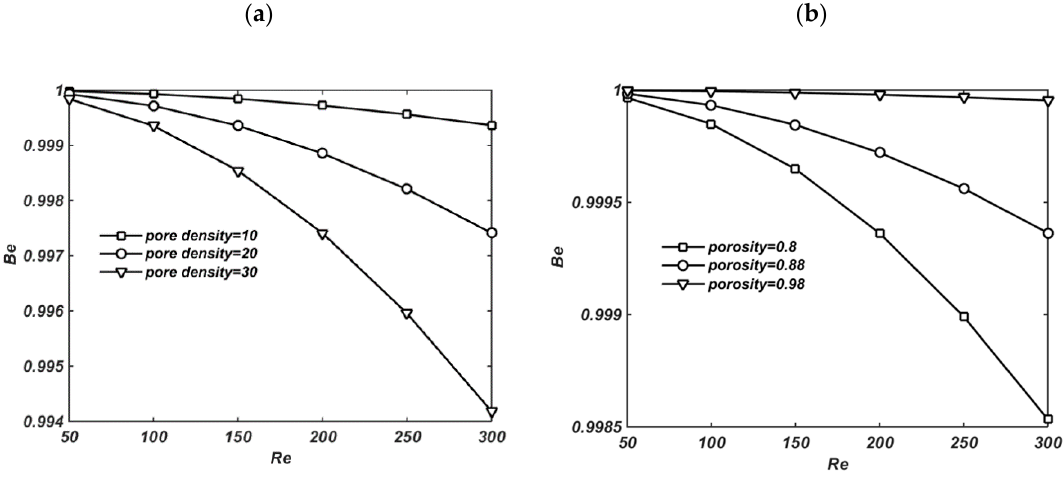
Figure 11. Bejan number as a function of Re for different values of pore density ω ( a ) and for different values of ε ( b ), respectively.